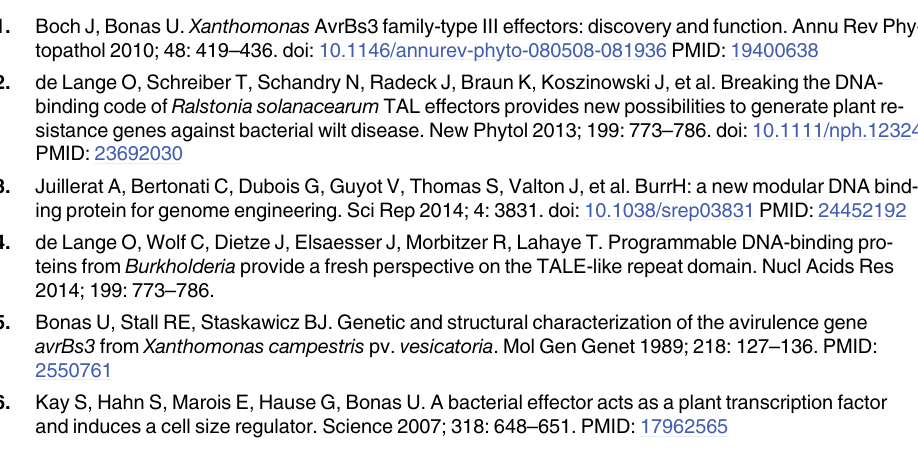
benthamiana . Leaf discs were harvested three dpi from the same areas as investigated in Fig. 4 and analyzed by immunoblot using an α -c-Myc antibody. S6 Fig. Expression of AvrBs3 deletion derivatives in N . benthamiana . Agrobacterium -medi- ated expression of 4× c-Myc-tagged AvrBs3 WT and deletion constructs in leaves of N . benthamiana . Samples were harvested three dpi from the same areas as investigated in Fig. 5, and analyzed by immunoblot using an α -c-Myc antibody. The uppermost bands correspond to AvrBs3 and derivatives. S7 Fig. Expression of AvrBs3 and LZm derivatives. (A) Agrobacterium -mediated expression of 4× c-Myc-tagged AvrBs3 and derivatives in leaves of N . benthamiana . Leaf discs were har- vested three dpi from the same areas as investigated in Fig. 6C and analyzed by immunoblot using an α -c-Myc antibody. (B) Expression of FLAG-tagged AvrBs3 and AvrBs3 derivatives in Xanthomonas . Xcv 85 – 10 derivatives with the respective plasmids were grown in NYG and an- alyzed by immunoblot using an α -FLAG antibody. GroEL was used as control for equal loading. S1 Table. Oligonucleotides used in this study. Names, sequences and purpose of the oligonu- cleotides are